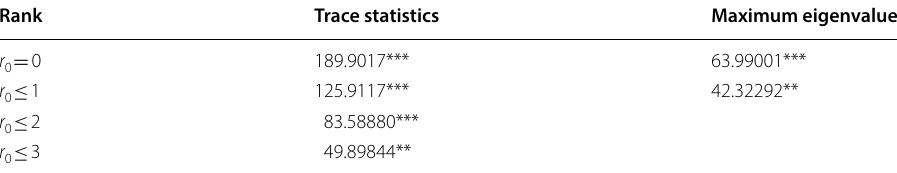
*** and ** indicate the rejection of null hypothesis at 1% and 5% significance levels, respectively